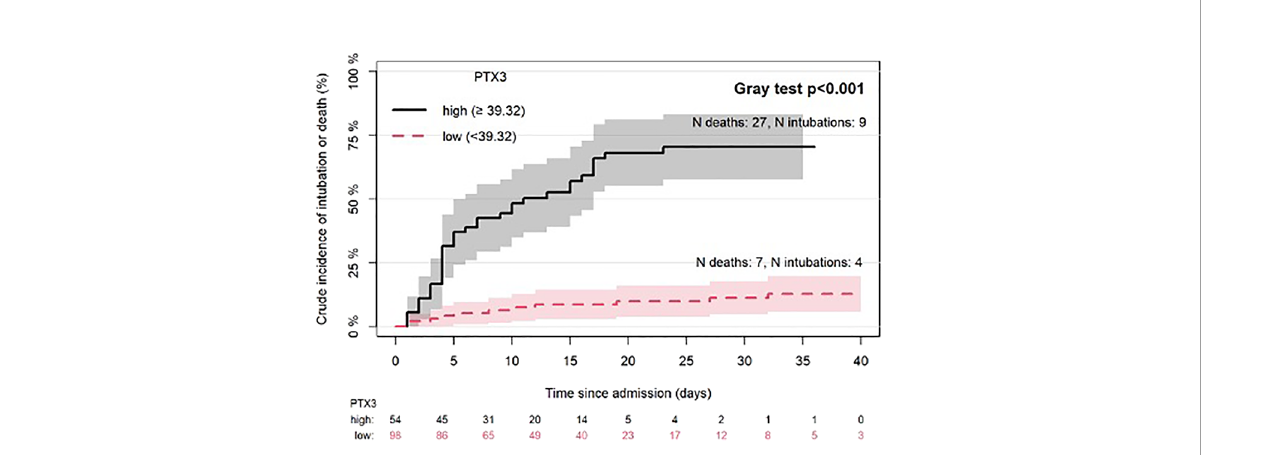
FIGURE 3 Crude incidence of intubation or death (discharge before intubation as competing risk) by PTX3 high or low (best cut-off based on Maximally Selected Rank Statistics method). List of abbreviations: N, number; PTX3, pentraxin 3. Lines represent the cumulative crude incidence of the outcome and the shaded areas its 95% con fi dence interval. The numbers below the plot indicate patients at risk in time in the two groups.